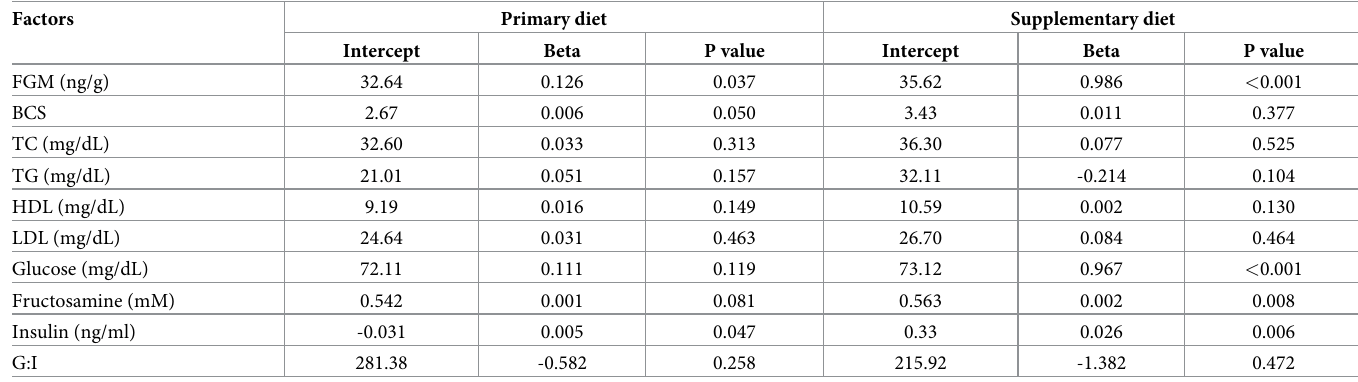
FGM = fecal glucocorticoid metabolites; BCS = body condition score; TC = total cholesterol; TG = triglycerides; HDL = high density lipoproteins; LDL = low density lipoproteins; G:I = glucose to insulin